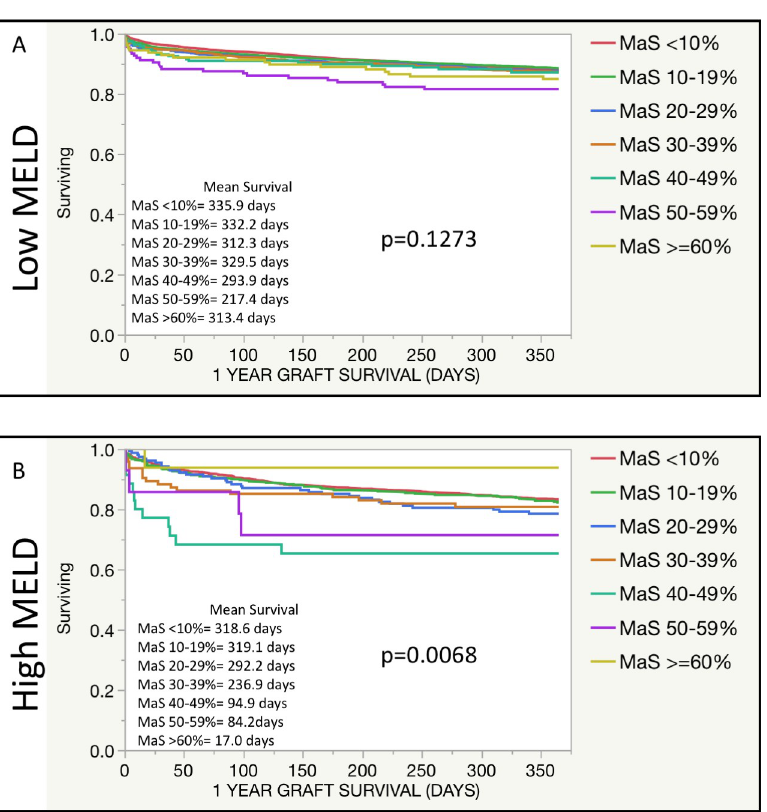
Fig 2. Allograft survival for organs with donor liver biopsy by MELD group. KM survival analyses were performed for 1-year allograft survival in Low MELD (A) and High MELD (B) recipients. Survival was compared across MaS groups. Allograft survival was truncated to 365 days; mean allograft survival is